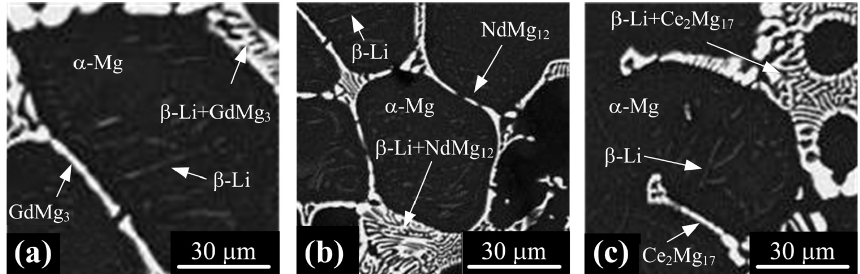
Figure 3. SEM images of as-cast (a) Gd-containing, (b) Nd-containing and (c) Ce-containing alloys.